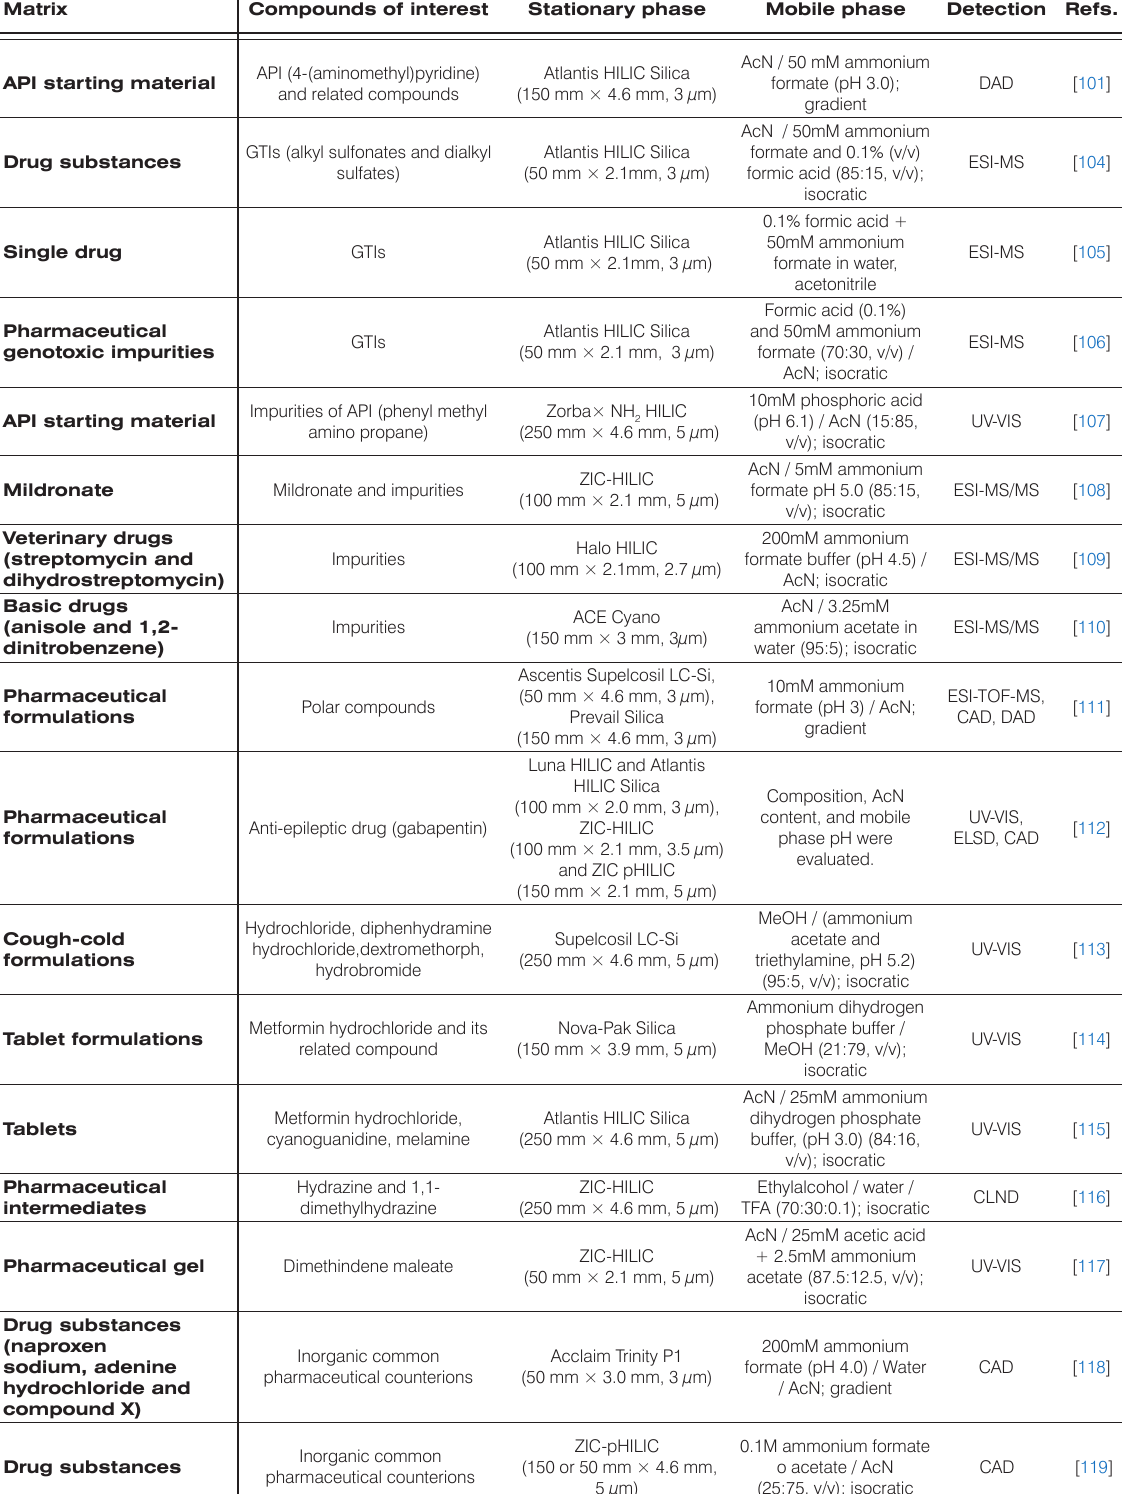
Table 2. - HILIC applications in drug analysis in pharmaceutical formulations and related